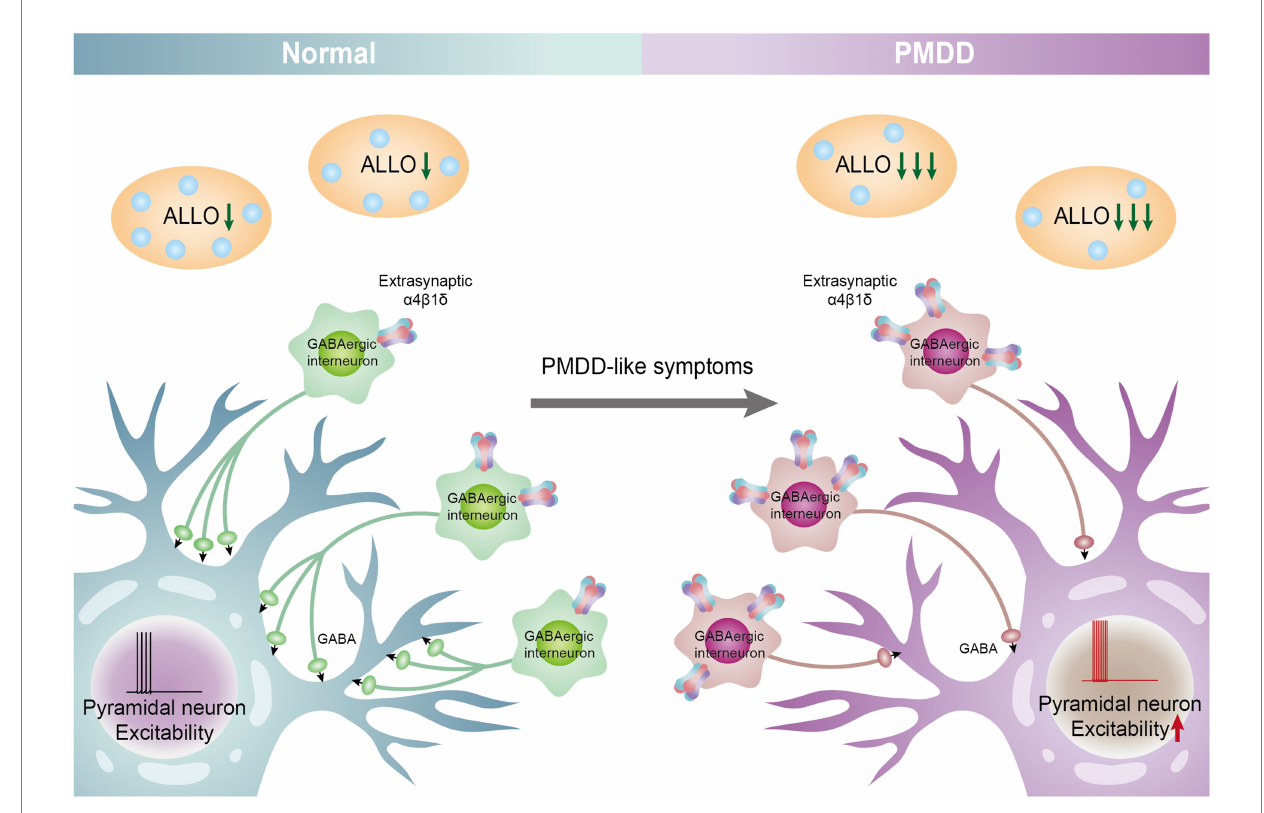
FIGURE 2 ALLO-mediated GABA A receptor subunit sensitivity participates in the pathogenesis of PMDD. When the decrease in ALLO is too rapid, there is an increase in the expression of GABA A receptor α 4 β subunits (10) and decreases in the sensitivity (decreased affinity, reduced plasticity), and leading to a decrease in chloride influx, which, in turn, inhibits the release of GABA from GABAergic interneurons, reduces the inhibition of pyramidal neurons, and then increases the excitability of pyramidal neurons, leading to the development of PMDD. The ALLO-mediated GABA A receptor remains the main pathogenic factor of